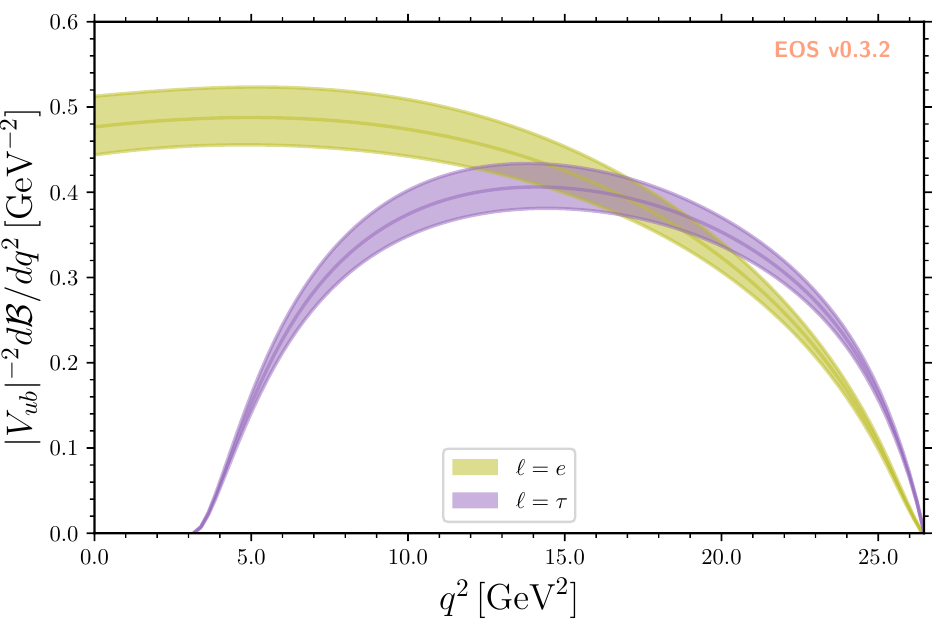
Figure 8 . Our Standard Model prediction of the differential decay rate of ¯ B → π‘ − ¯ ν ‘ divided by | V ub | for the electron and tau final states. The form factors are obtained from a fit to both LCSR and LQCD inputs using modified BCL parametrization in the K = 4 fit model.